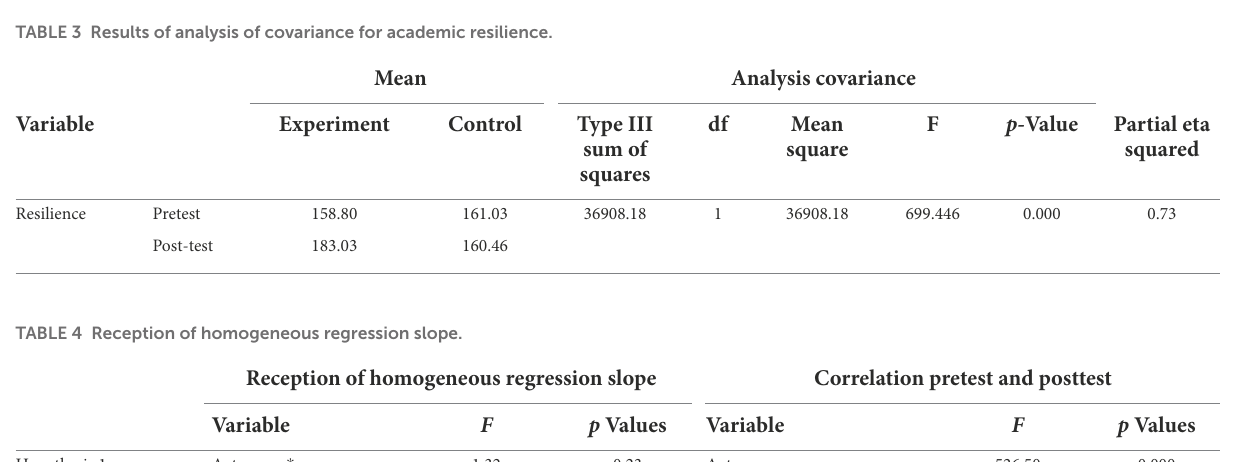
TABLE 3 Results of analysis of covariance for academic resilience.